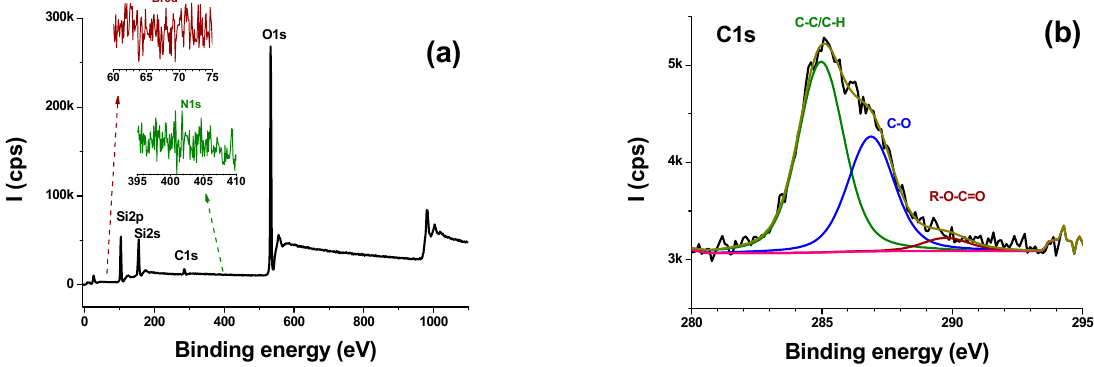
Figure 2. Survey ( a ), and peak-fitted C1s ( b ) spectra of MSPs. N1s (green) and Br3d (red) narrow regions are shown in inset of ( a ).